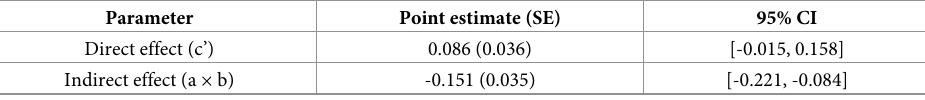
Table 1. Mediation analysis of emotion between social exclusion and WM performance in the sham stimulation